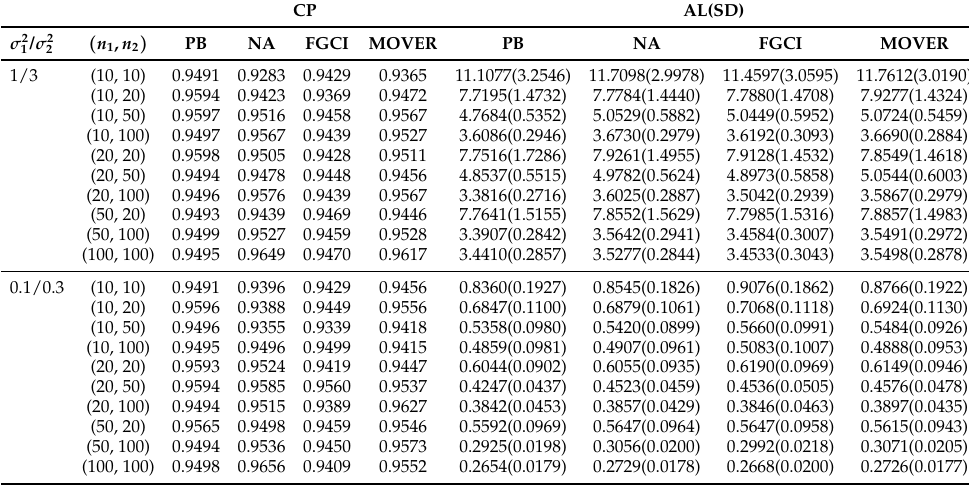
= 0.1 and σ 2 = 0.2. 2 1